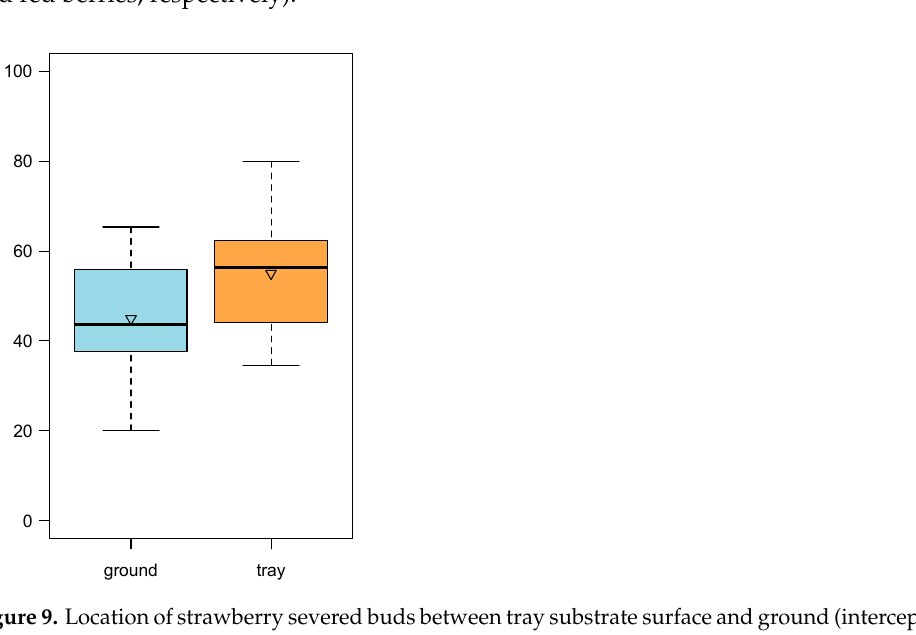
Figure 8. Survival rate of immature stages inside blackberry severed buds deployed on grass ( n = 4) or on black polypropylene woven groundcover fabric ( n = 4). The boxes enclose the first and third quartiles; the ends of the whiskers represent the 5th/95th percentiles, the solid lines the median and the triangle the mean.